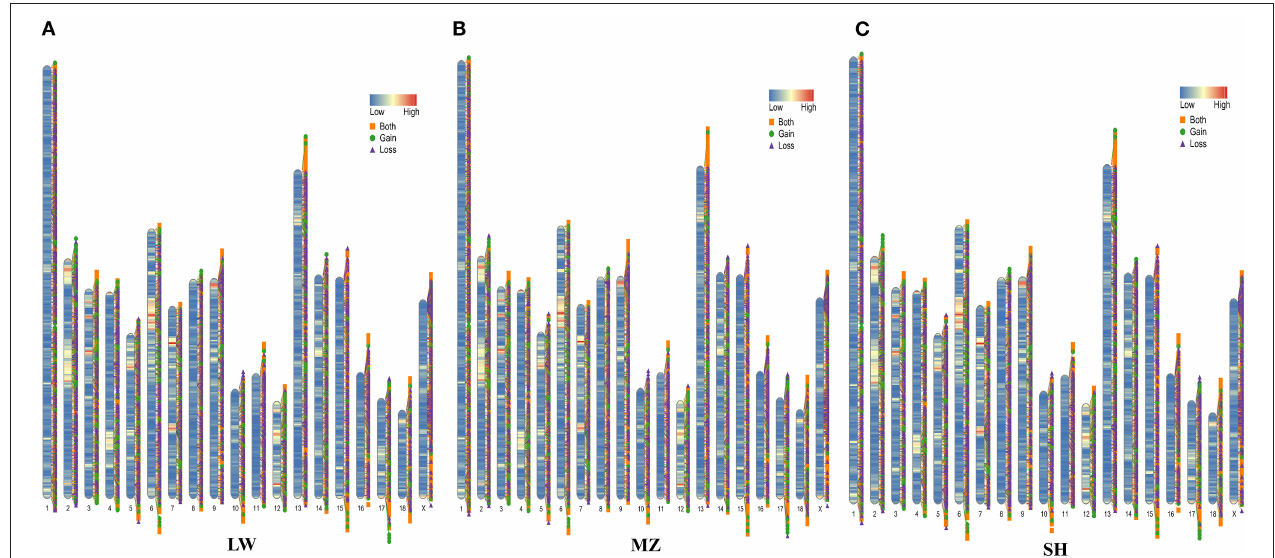
FIGURE 1 | The genome distribution of CNVRs and variation types of LW (A) , MZ (B) , and SH (C) pigs. The legend of “Low” to “High” indicates the gene density on the pig chromosomes. The yellow square represents the both type, the green circle represents the gain type, and the purple triangle represents the loss